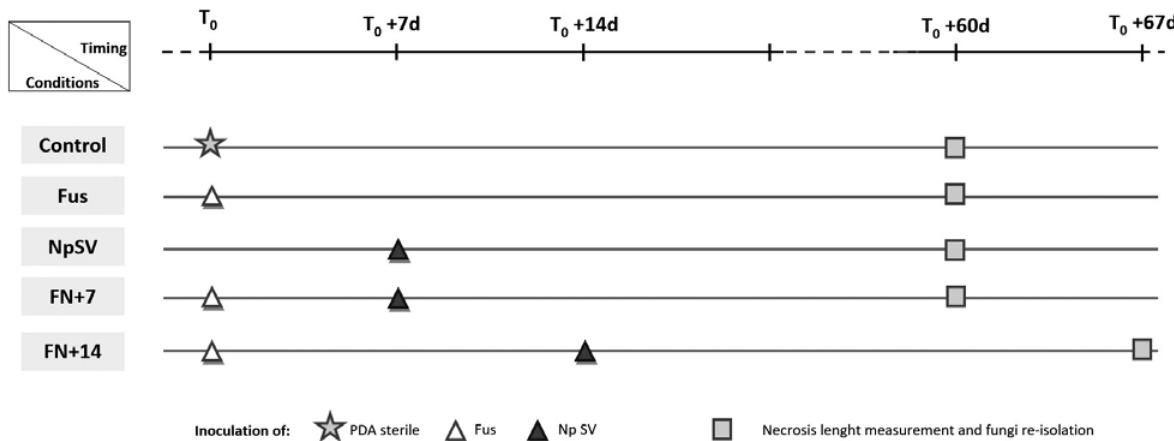
Figure 1. The co-inoculation test scheme, indicating the different conditions assayed and the timing of the inoculations BCA –pathogen, as performed in the greenhouse